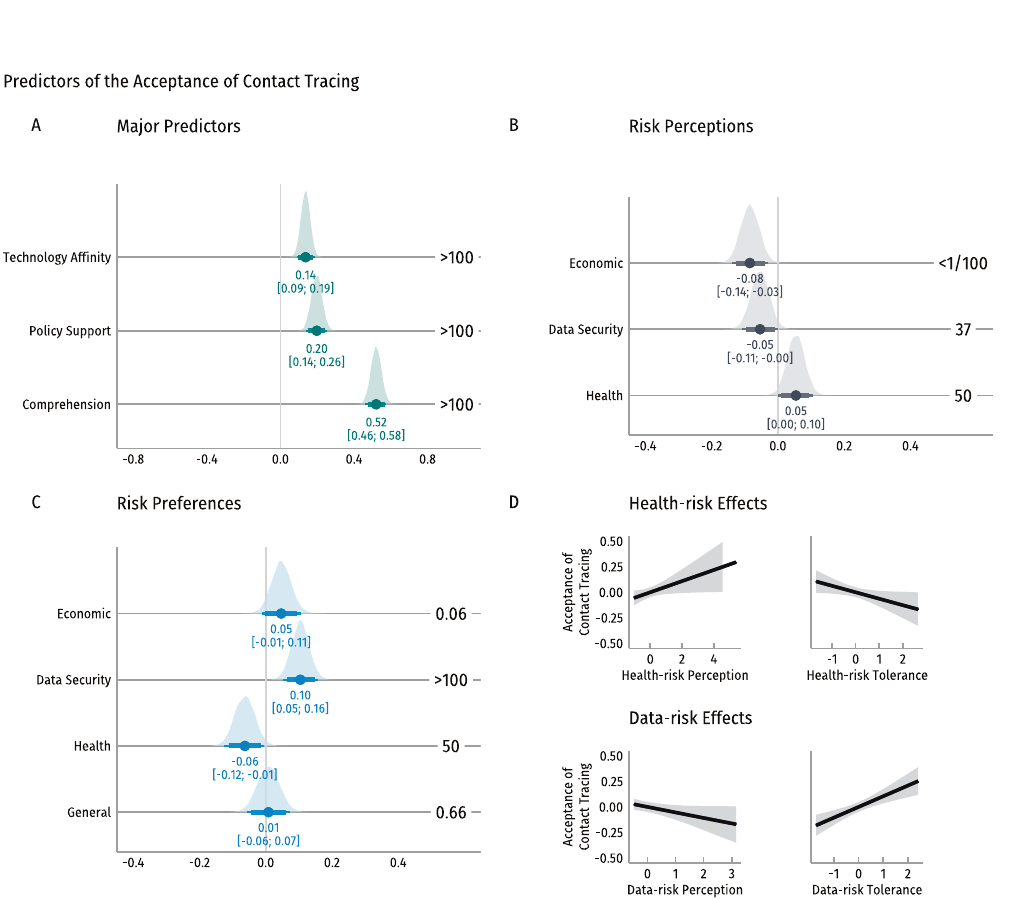
Fig. 3 Factors that in fl uence the acceptance of digital contact-tracing applications. A – C Effects on acceptance of contact tracing (the posterior estimates of regression coef fi cients). Points = median posterior estimate, interval = 95% highest density intervals, bold numbers in the lines = Bayes factors in favor of the hypotheses. D Fitted effects of increasing health-risk perception compared to increasing health-risk tolerance and increasing data-security-risk perception compared to data-security-risk tolerance (labelled as with M = 0 and SD = 10; policy support β = 0.20, 95% HDI 0.14 – 0.26, BF ( + ) > 100]. In terms of psychological factors, accepting DCTAs was Fig. 3A [for the predictor comprehension of DCTAs, the median β = 0.52, 95% highest density interval (HDI) 0.46 – 0.60, evidence risk ( β = 0.05) and negatively related to perceiving DCTAs as a in favor of a positive effect BF ( + ) > 100 based on a normal prior